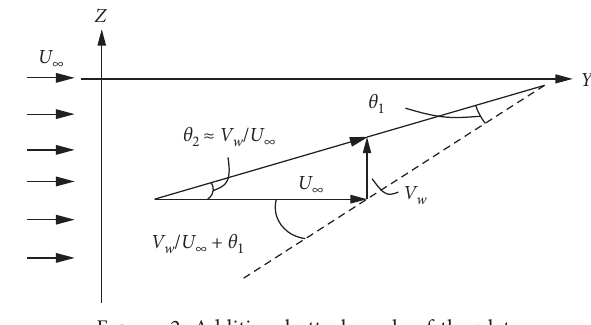
Figure 2: Additional attack angle of the plate.